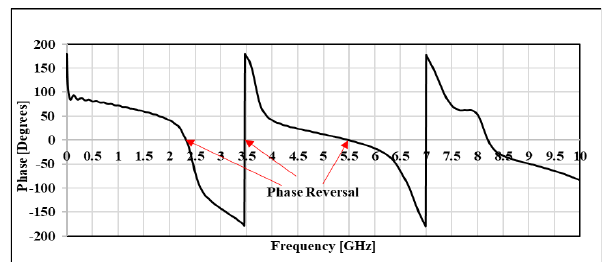
. Figure 12. Reflection parameter (S 11 ) of a unit cell in degrees for phase reversal.